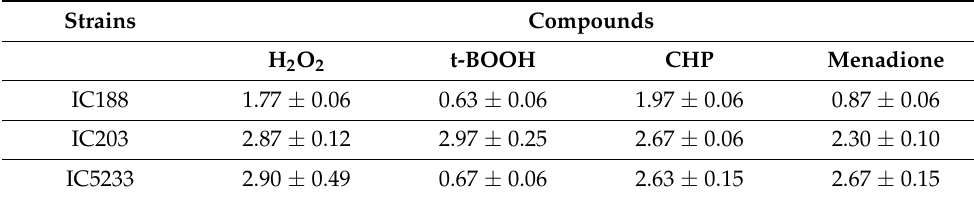
Table 1. Sensitivity of the different strains to oxidants in the growth inhibition test. Strains Compounds H 2 O